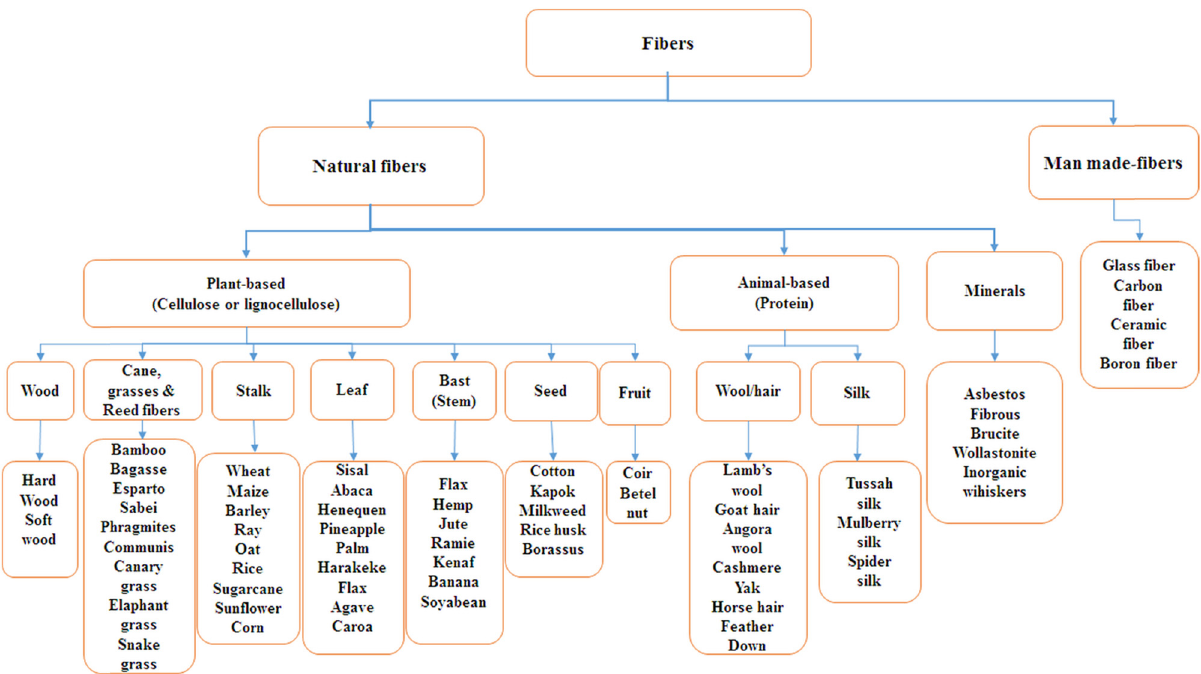
Figure 2: Classi fi cation of natural and man - made fi